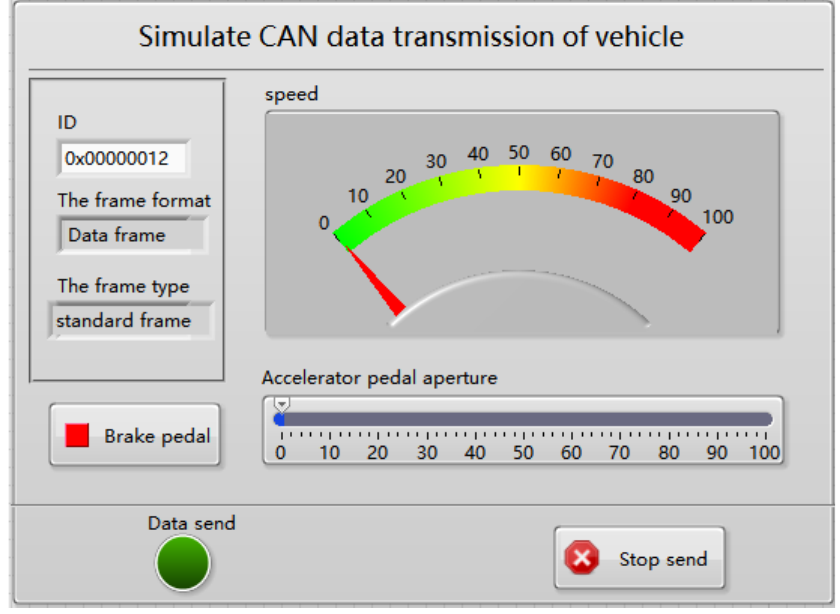
Figure 20. CAN data sending process of the upper computer.